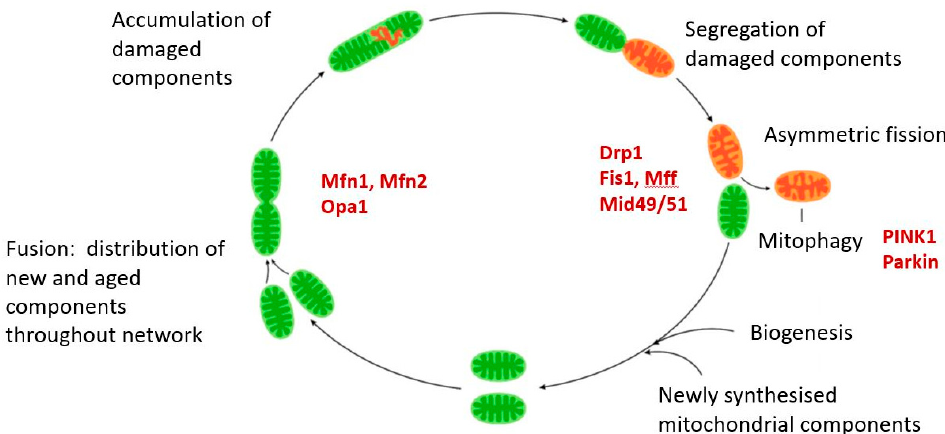
Figure 10. The mitochondrial life cycle. Newly synthesized components are added to existing mitochondria. These are shared throughout the mitochondrial pool by cycles of fission and fusion which constitute part of the mitochondrial life cycle. Fusion events are critically dependent on mitofusin s 1 and 2 and the inner membrane GTPase Optic Atrophy-1 (OPA1). Fission is initiated by recruitment of the cytosolic GTPase dynamin-related protein 1 (DRP1) to the mitochondrial surface, where it docks with one of several receptors, Fis1, mitochondrial fission factor (M ff ), Mid 49 or Mid 51. Damaged molecules are segregated and asymmetric fission results on one daughter with normal mitochondrial membrane potential, the other containing the damaged molecular constituents and having a low membrane potential (MMP). This low potential triggers mitophagy by the recruitment of the PTEN-induced kinase 1 (PINK1), which then activates the E3 ubiquitin ligase Parkin. Ubiquitinated mitochondria are then disposed of by mitophagy. Additional pathways to trigger the removal of damaged mitochondria have been described and these may be initiated by signals other than reduced MMP, such as externalized cardiolipin.